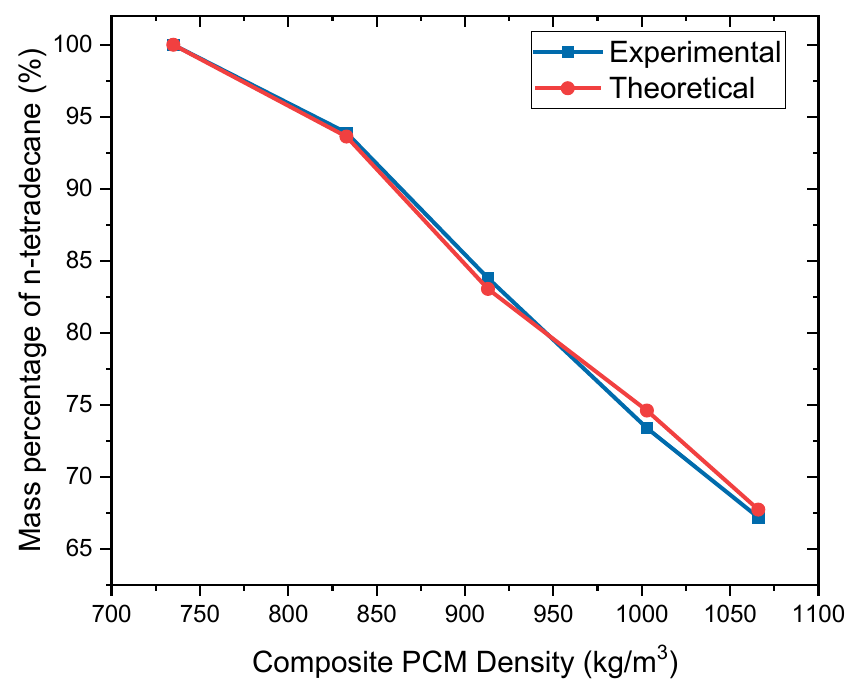
Figure 8. Validation of the model to predict the maximum adsorption rate of paraffin.